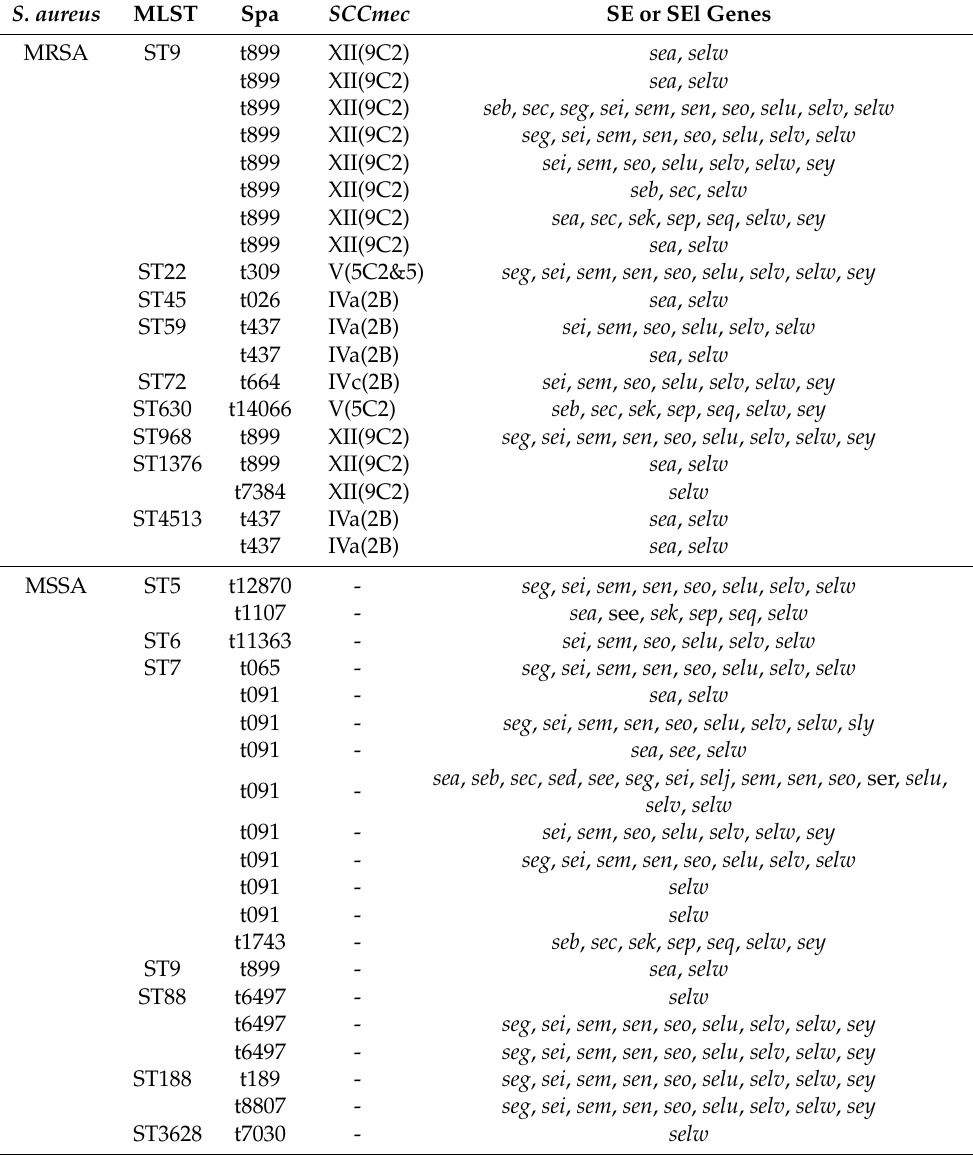
Table 3. ST, spa , SCC mec , and SE or SEl genes identified in the S. aureus isolates from wholesale and retail pork in Wuhan, central